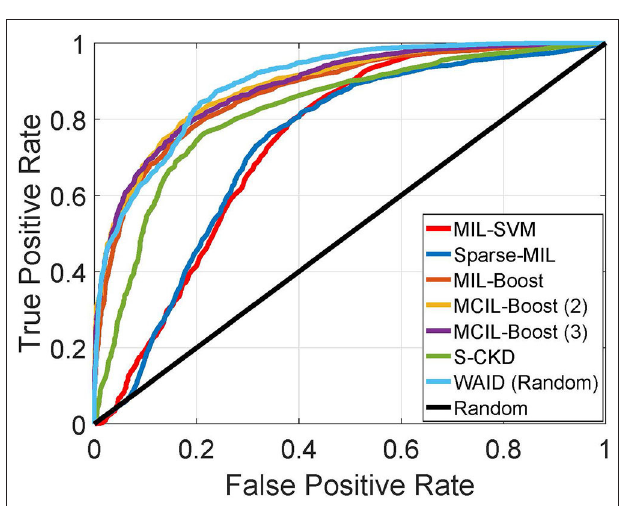
FIGURE 8 | ROC curve for experiments against MIL schemes on BreakHis (Best if viewed in